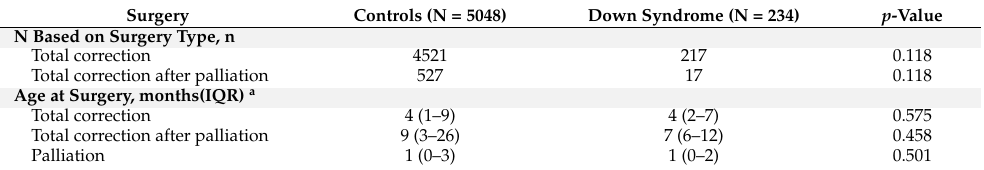
Table 3. The type of and age at surgery in patients with and without Down syndrome who underwent total